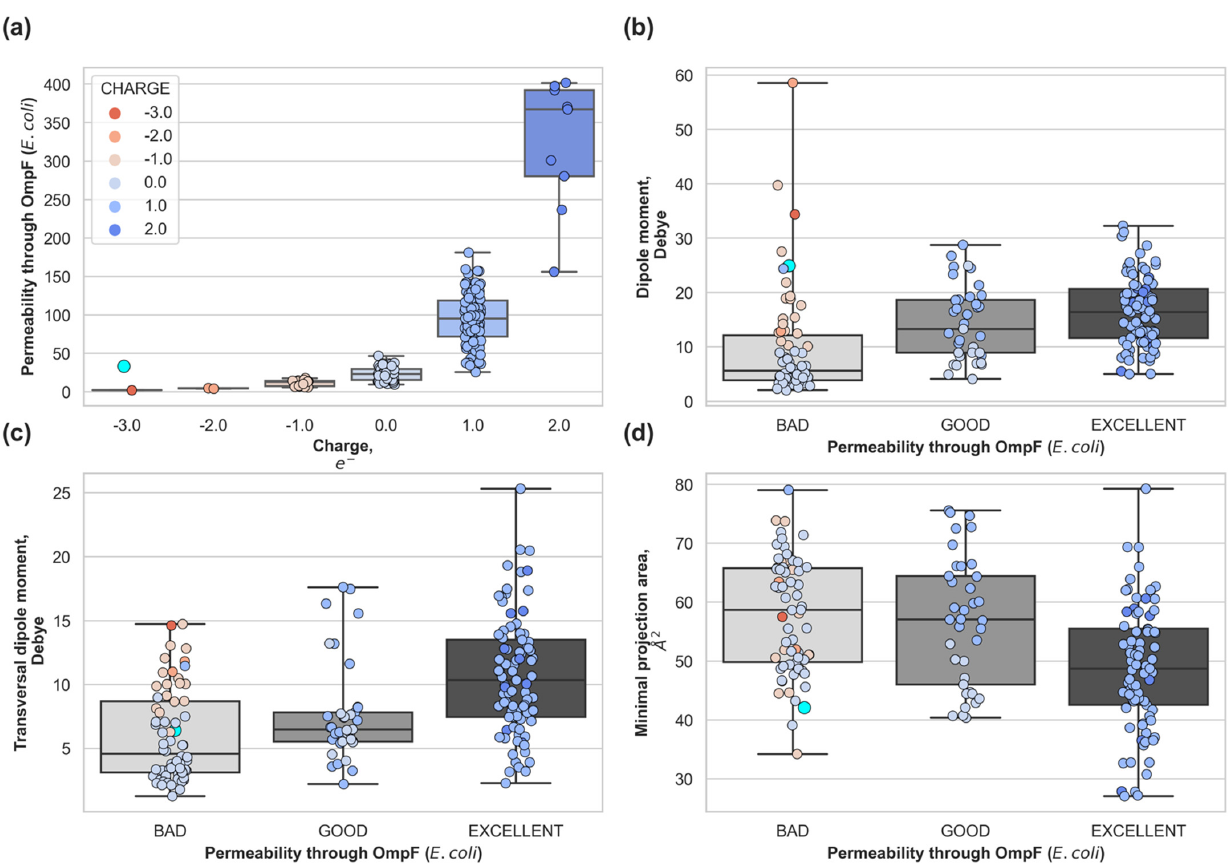
Figure 3. ( a ) Predicted permeability distribution according to the total charge of the compound. Molecular descriptors: ( b ) total dipole moment, ( c ) transversal dipole moment and ( d ) minimal projection area; for compounds with non-negligible accumulation grouped by predicted permeability through the major OmpF of E. coli . Very bad permeability (<30%), poor permeability (<50%), good permeability (70%), and excellent permeability (>70%). Percentages are relative to the measured [25] permeability coefficient of glycine through OmpF. Compound 183 (zwitterionic) is highlighted as a cyan dot with bigger marker size.